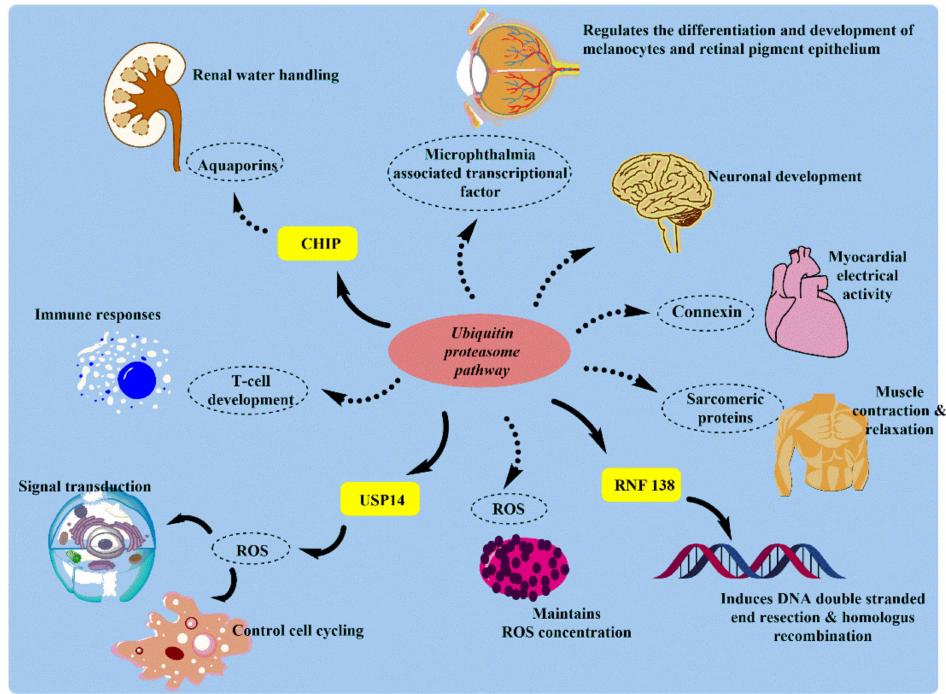
Figure 4. This figure summarizes the pathophysiological role of UPP in various diseases and indicates the dysregulated enzyme in the respective